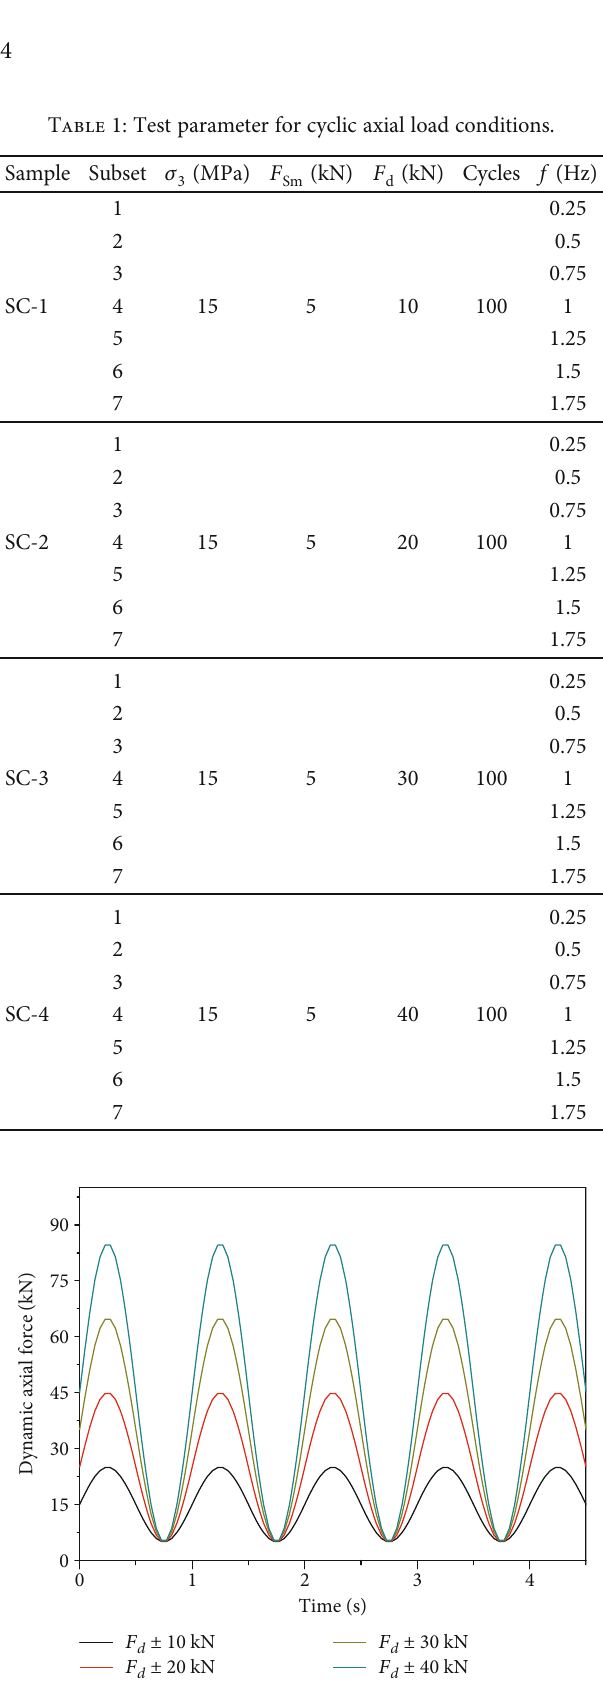
Figure 3: Schematic of loading paths with a frequency at